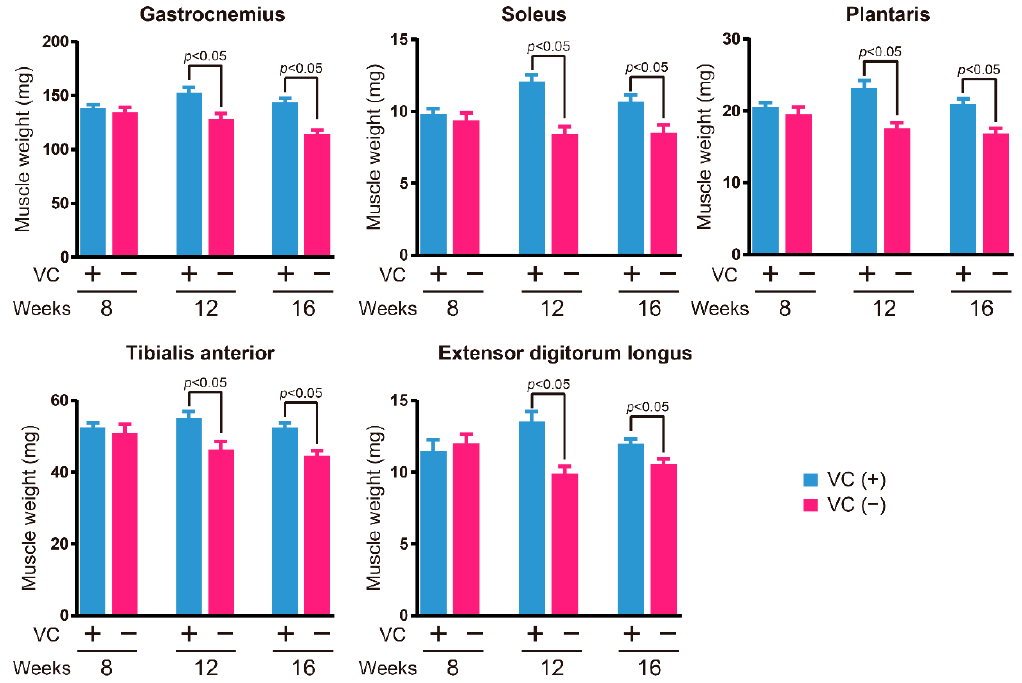
Figure 2. Skeletal muscle weight during VC deficiency. At eight, twelve, and sixteen weeks, n = 5 and 5, n = 10 and 10, and n = 9 and 15 mice each for VC(+) and VC( − ) groups, respectively. Values are given as the mean ± SEM. Statistical differences were considered significant at p < 0.05 between VC(+) and VC( − ) groups.